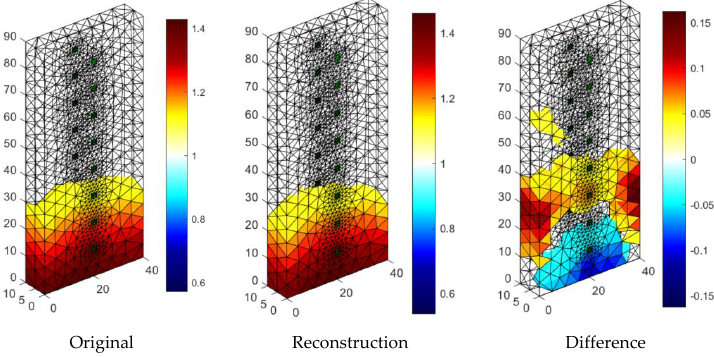
Figure 17. The result of ElasticNet moisture testing of the lightweight concrete block for the case of 2 × 8